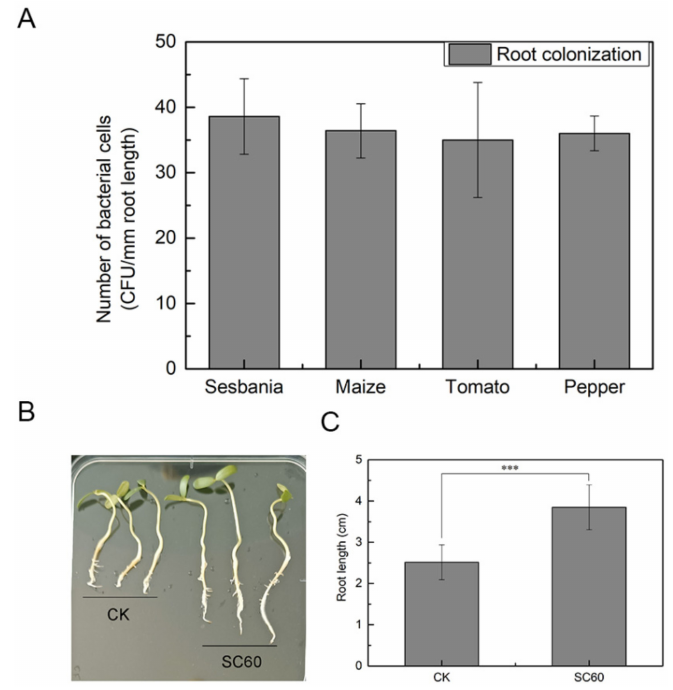
Figure 3. Colonization and root growth-promoting ability of strain SC60. ( A ) Root surface colo- nization of strain SC60. Error bars indicate the standard deviations based on five independently replicated experiments. ( B ) Effects of strain SC60 on root development of Sesbania cannabina . CK is the control group. The length of root is measured and the statistics are shown in Figure C ( C ) Quantitative data on growth of Sesbania cannabina . Error bars indicate the standard deviations based on six independently replicated experiments and asterisks (***) above the bars indicate significant differences ( p < 0.001). Table 3. PGPR trait-associated genes identified in the SC60